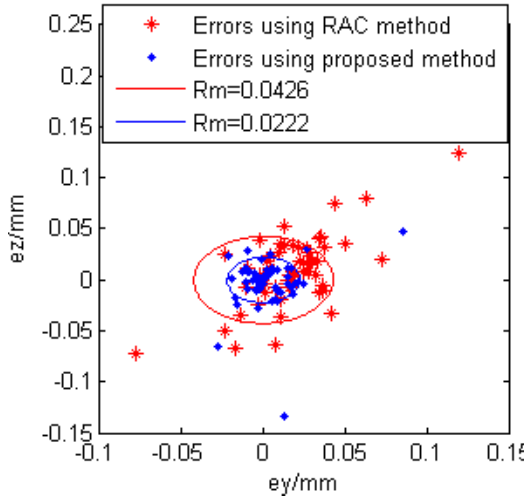
Figure 16. Error distribution from the image coordinates to the world coordinates. Table 2. Test camera calibration accuracy obtained by the RAC and proposed method.